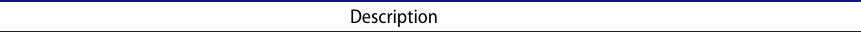
Table 2. Proposal for a Swedish Cohort Consortium